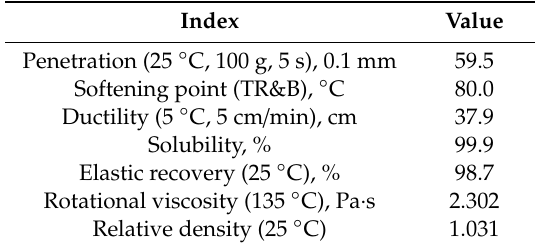
Table 1. Properties of styrene–butadiene–styrene (SBS) modified